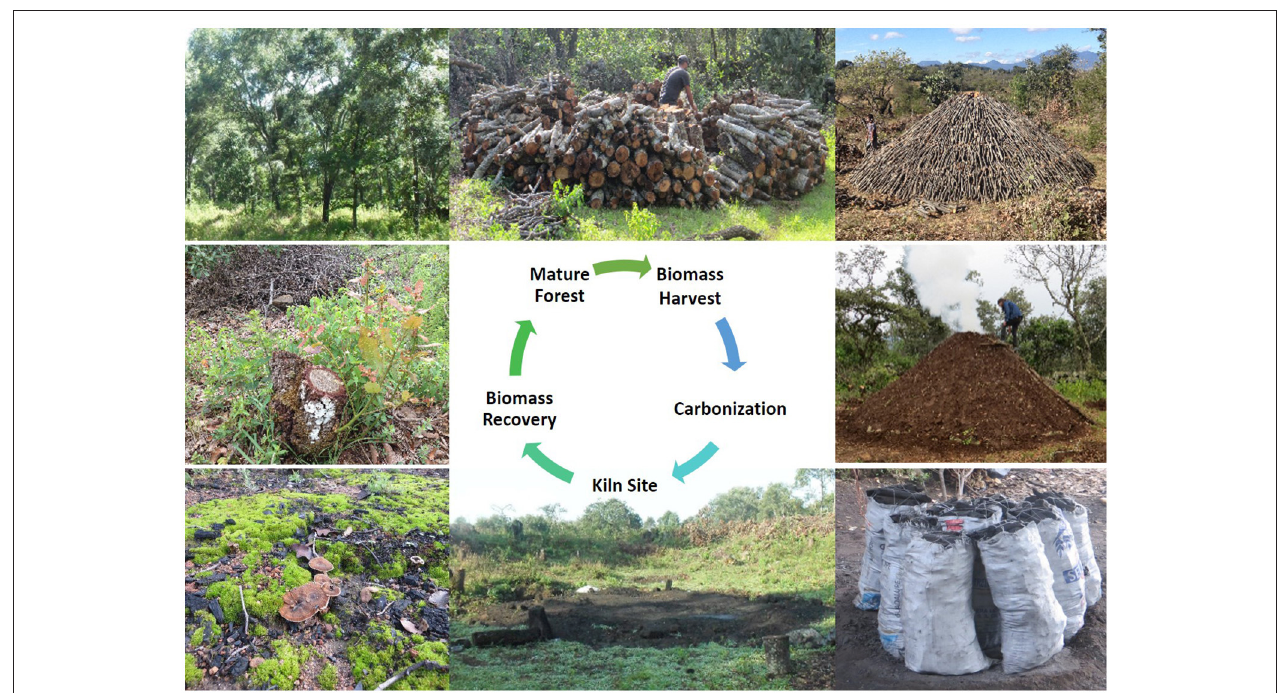
FIGURE 1 | Key stages in a typical traditional system in which forests or woodland are managed for (among other things) charcoal production. Clockwise from upper left corner: Wood is harvested from mature forests, different sized logs are stacked above or below-ground to form a rectangular or conical kiln that is insulated with locally available material such as, grass and earth. Once lit, the process of carbonization converts the wood to charcoal which is subsequently packed into sacks that are sold to intermediaries. With time ( > 20 years), the kiln site recovers some vegetation. In felled areas, tree stumps coppice in 2–4 weeks to initiate the biomass recovery period which lasts from 8 to 30 years before the cycle is repeated. Livestock are typically an integral part of this system, present in all or only some of the stages. Photos courtesy of